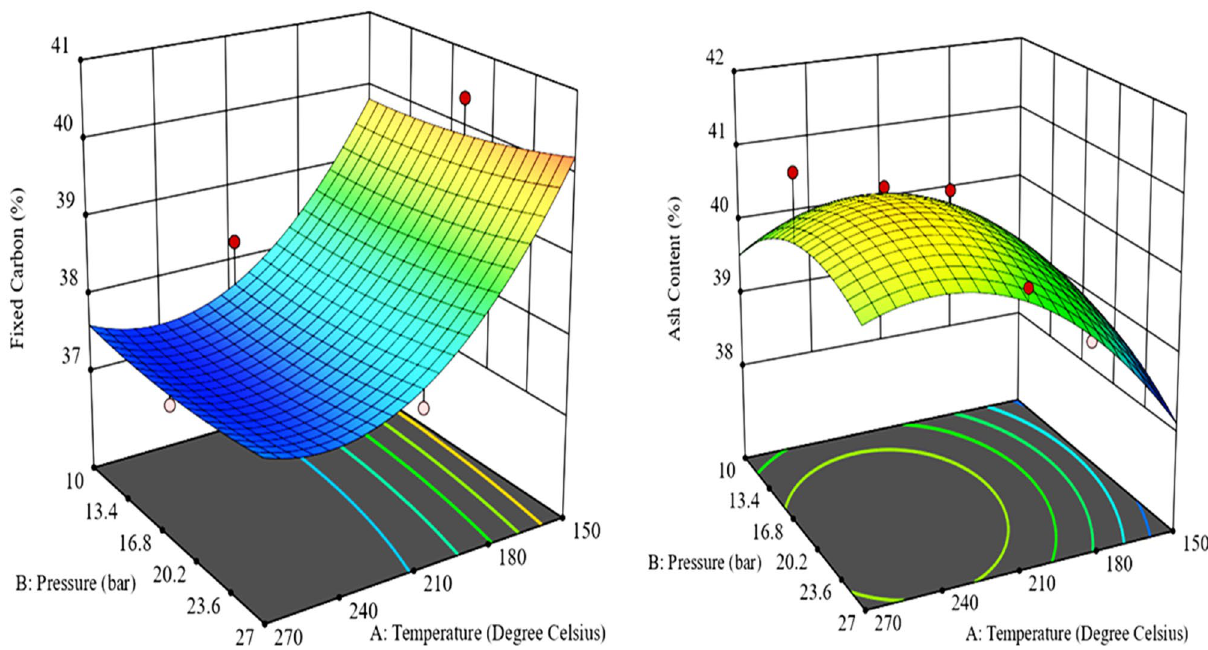
Figure 5. Surface plot showing the influence of temperature and pressure on fixed carbon (left) and Ash content (right) of Coal tailing’s